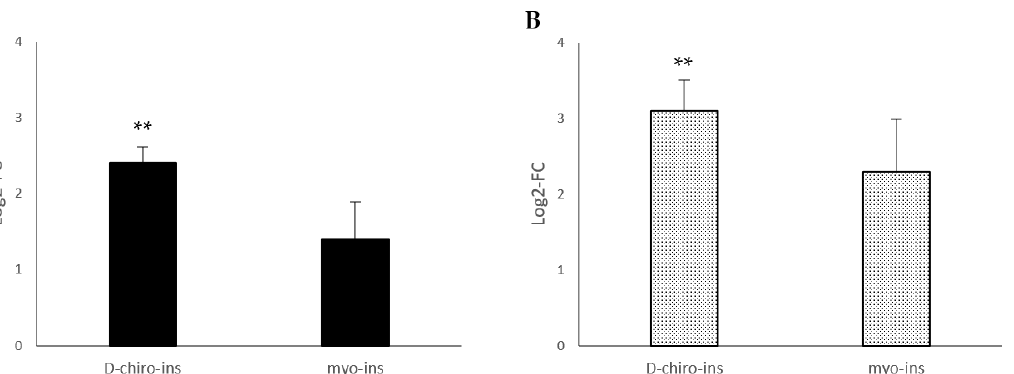
(Figure 3A). In the case of LiSa-2 cells (Figure 3B), the treatment with D-chiro-Ins recorded significant differences in oxygen consumption except for the 10 min timepoint, while myo- Ins-treated cells exhibited higher oxygen consumption with respect to untreated cells in all the timepoints except for 25 min. The only significant differences between the treatments with myo-Ins and D-chiro-Ins were recorded at 5 and 25 min in SGBS cells and at 30 and 40 min in LiSa-2 cells. Figure 2. Modulation of mitochondrial DNA copy number in ( A ) SGBS cells and ( B ) LiSa-2 cells. SGBS and LiSa-2 di ff erentiated adipocytes were treated with D-chiro-Ins (60 µM) and myo-Ins (60 µM) for 72 h, with a single medium change at 36 h. Results are reported as mean ± SD of data